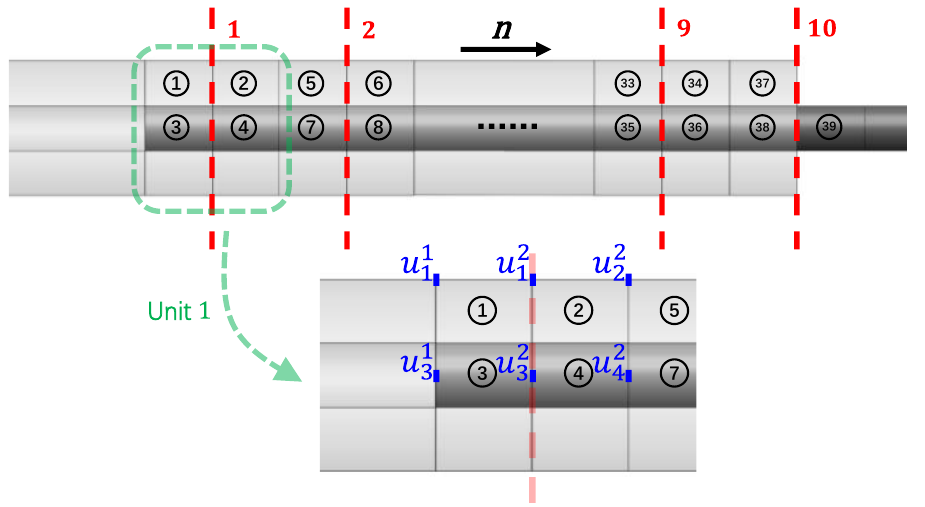
Figure 2. Case 1, the outer tube – inner tube.